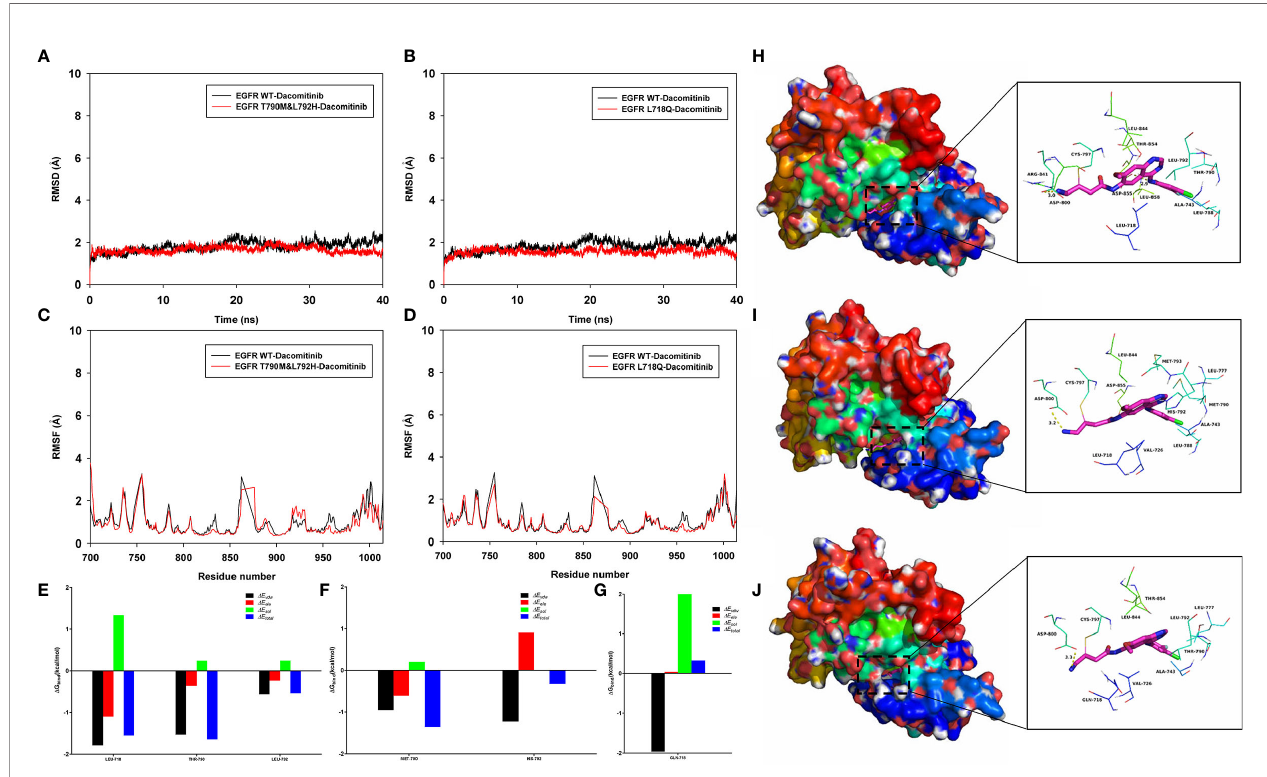
FIGURE 2 | Molecular dynamics simulation. The root-mean-square deviation (RMSD) values of the protein backbone based on the starting structure along the simulation time were calculated and plotted in (A, B) , and the protein structures of the three systems (EGFR WT-Dacomitinib, EGFR T790M&L792H-Dacomitinib, EGFR L718Q-Dacomitinib with Dacomitinib) were stabilized during the 40-ns simulation. The root mean square fl uctuations (RMSF) of residues are shown in (C, D) . The summations of the per residue interaction free energies were separated into Van der Waals ( D E vdw ) (black), solvation ( D E sol ) (green), electrostatic ( D E ele ) (red) and total contribution ( D E total ) (blue). In the EGFR WT-Dacomitinib complex, the residues L718 and T790 with the D E vdw of < -1.5 kcal/mol (E) , have an appreciable Van der Waals interactions with the Dacomitinib because of the close proximity between the residues and the Dacomitinib (H) . In the EGFR T790M&L792H-Dacomitinib complex, the residues M790 and H792 decomposed energy interaction originated from Van der Waals interactions, and the total contribution were both higher than that of EGFR WT (F, I) . In the EGFR L718Q-Dacomitinib complex, the residue Q718 decomposed energy interaction originated from Van der Waals interactions, and the total contribution was higher than that of EGFR WT (G, J)